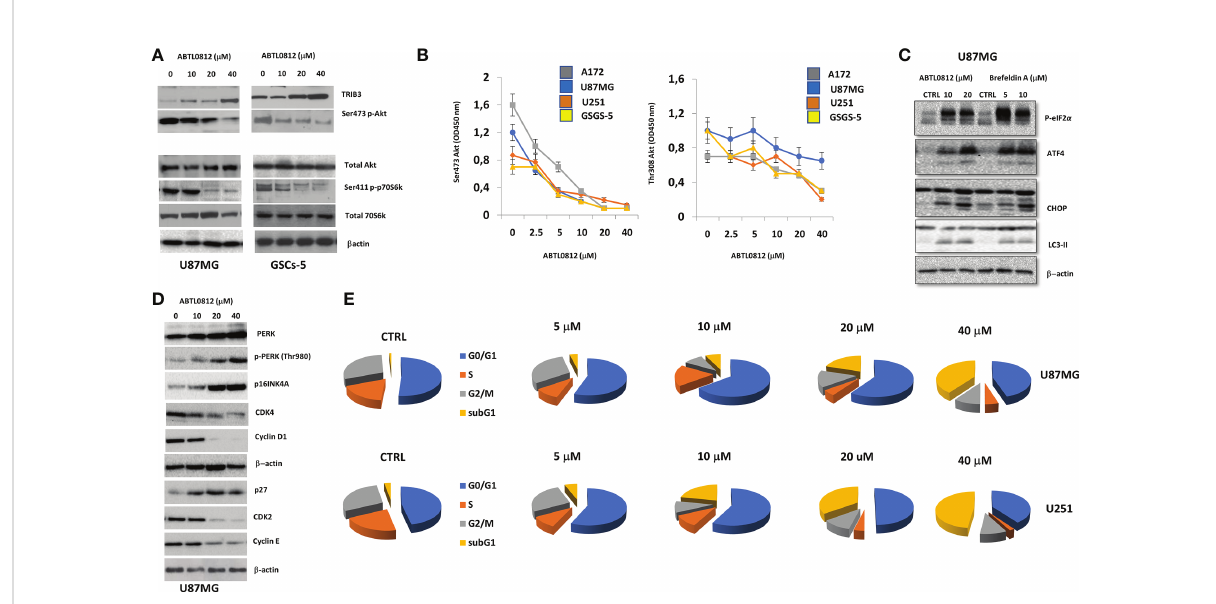
FIGURE 5 ABTL0812 inhibits Akt/mTORC1 axisA and induces ER stress (A) Representative immunoblotting images of Akt/mTORC1 axis markers TRIB3, Akt and p70S6K from U81MG cells treated with ABTL0812 for 16 hours. (B) ELISA quanti fi cation of p-Akt Ser473, and p-Akt Thr308 in U81MG, U251, A172 and GSCs-5 cells treated with ABTL0812 for 16 hours (C) Representative immunoblotting images of p-eIF2 a , ATF4, CHOP and LC3-II from U81MG cells treated with ABTL0812 for 16 hours The ER stress inducer Brefeldin A was used as a positive control for ER stress response (D) Representative immunoblotting images of PERK and phase G1-S cell cycle regulators from U81MG cells treated with ABTL0812 for 16 hours. (E) Diagrams showing percentages of cell population in each cell cycle phase in U87MG and U251 cells treated with ABTL0812 for 16 hours determined by fl ow citometry analysis of propidium iodide-stained